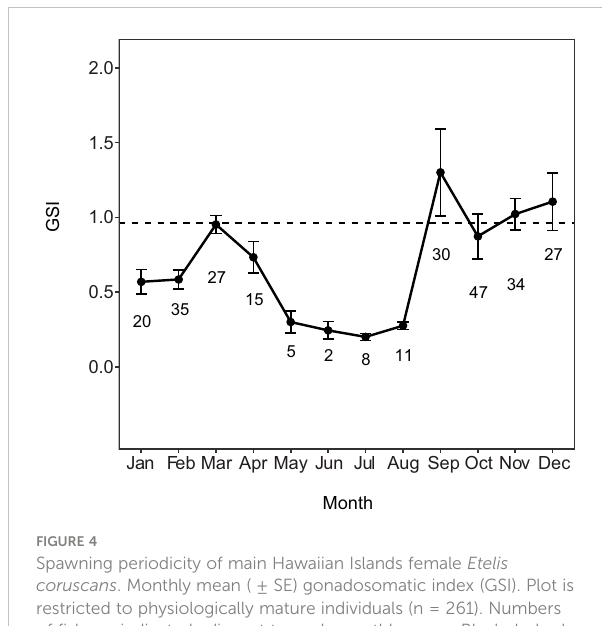
FIGURE 4 Spawning periodicity of main Hawaiian Islands female Etelis coruscans . Monthly mean ( ± SE) gonadosomatic index (GSI). Plot is restricted to physiologically mature individuals (n = 261). Numbers of fi sh are indicated adjacent to each monthly mean. Black dashed line indicates the GSI value (0.962) for reproductively active fi sh.